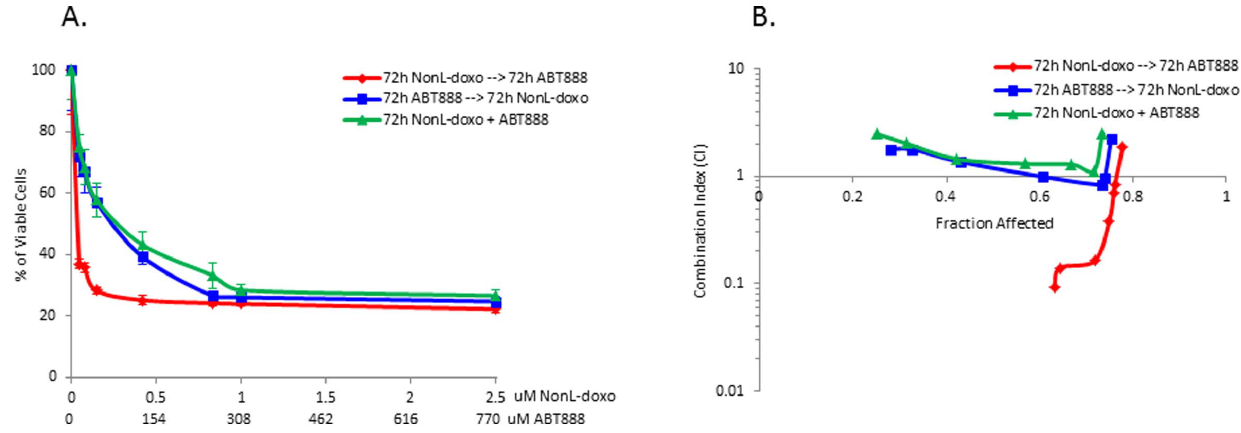
Figure 4. Sequential and combination treatment of the MDA-MB-231-BR cell line with ABT-888 and non-liposomal doxorubicin (NonL-doxo). ( A ) Percentage of viable cells treated in each of three treatment arms (72 hours [h] ABT-888 followed by 72 h NonL-doxo [blue], 72 h NonL-doxo followed by 72 h ABT-888 [red], and 72 h concurrent schedule of NonL-doxo and ABT-888 in combination [green]). ( B ) Combination index (CI) analysis in each arm compared to treatment with single agents. Note: CI , 0.1–0.9, synergy; CI 0.9–1.1, additivity; CI . 1.1,